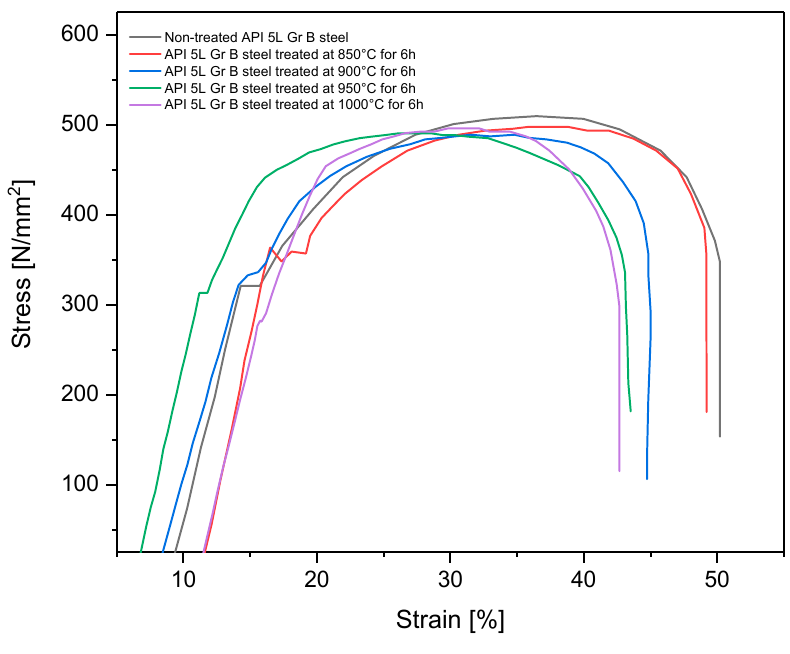
Figure 11. Strain–stress curve for treated and non-treated API 5L grade B steel. The tensile test obtained the yield strength, UTS, percent of reduction of area, and percent of elongation. These results are listed in Table 5. Table 5. Yield strength, UTS, reduced area, and elongation for treated and nontreated specimens. Condition